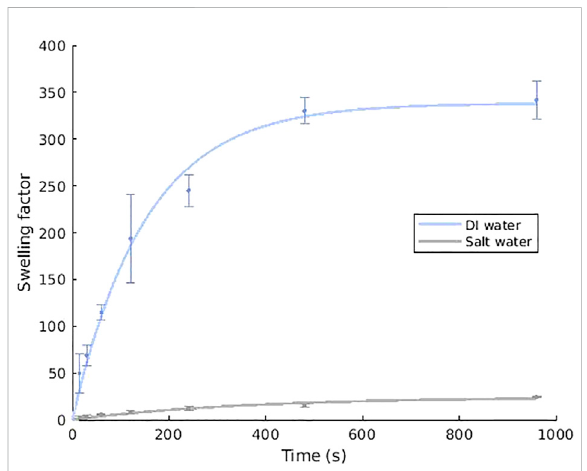
FIGURE 3 The swelling behaviour of sodium polyacrylate powder in deionised and salt water (4% w/w). The fi tted curves use SF m , ∞ = 338.26 and 24.37, and τ = 151.06 s and 352.95 s for deionised water and salt water respectively. Error bars show one standard